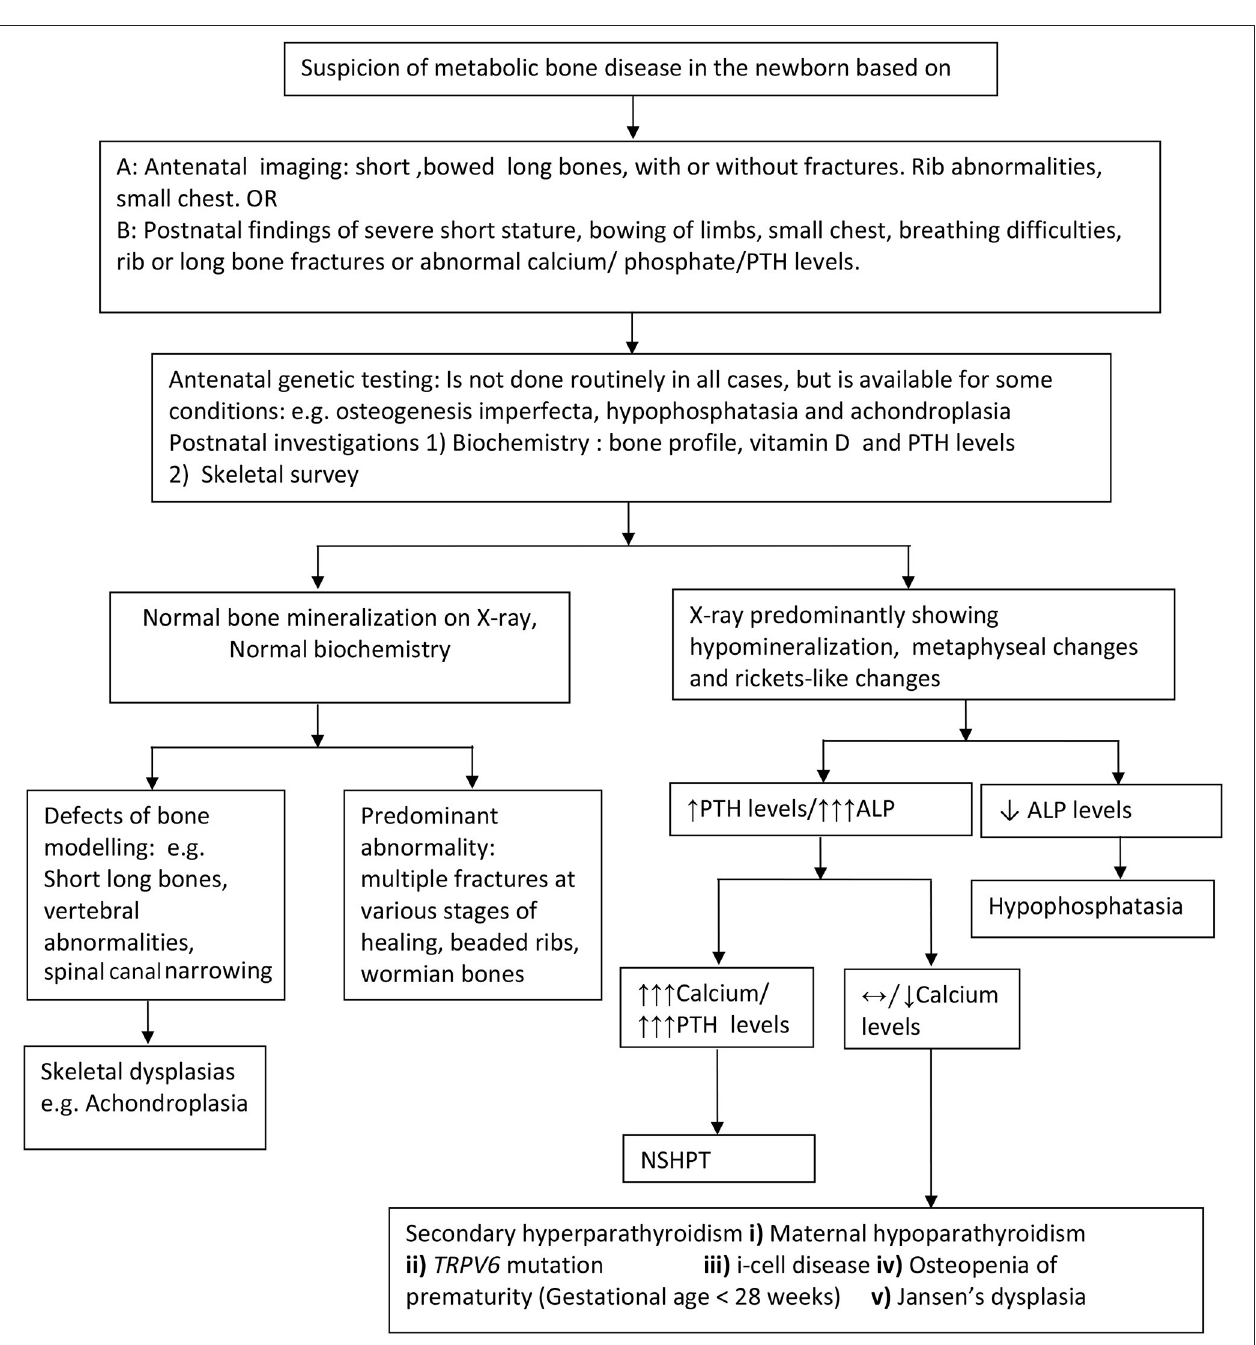
FIGURE 2 | Approach to the diagnosis of metabolic bone disorders in the newborn. PTH, parathyroid hormone levels; ALP, Alkaline phosphatase; NSHPT, neonatal severe hyperparathyroidism; TRPV6, transient receptor potential cation channel, subfamily V, member 6.